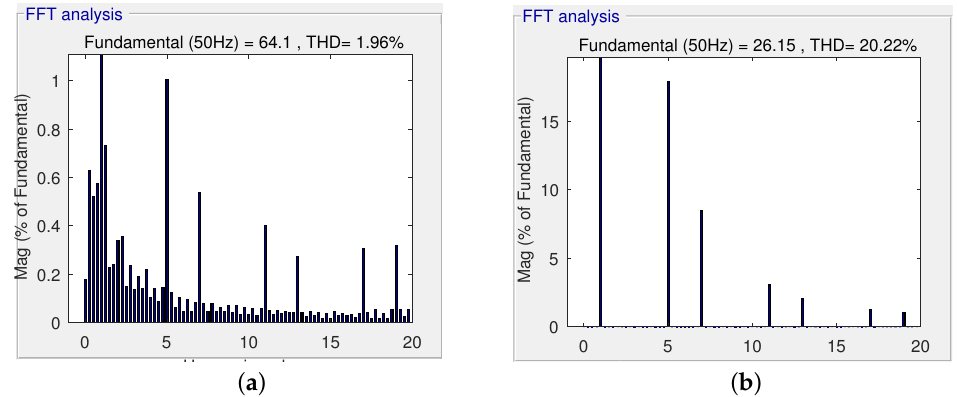
Figure 9. Total harmonic distortion (THD) analysis of grid and load current under conditions with 0 < P L < P p . ( a ) THD analysis of grid current and ( b ) THD analysis of load current. v